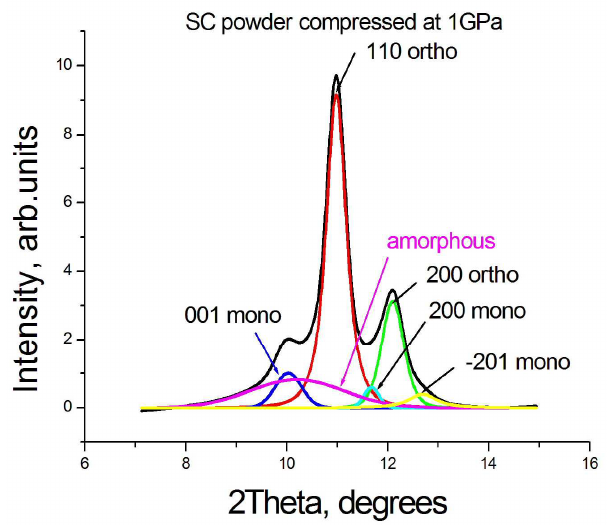
Figure 3. An example of the decomposition of the WAXS experimental pattern using the Fityk 3.0 program. The diffraction peaks were approximated by Pearson VII profile function.